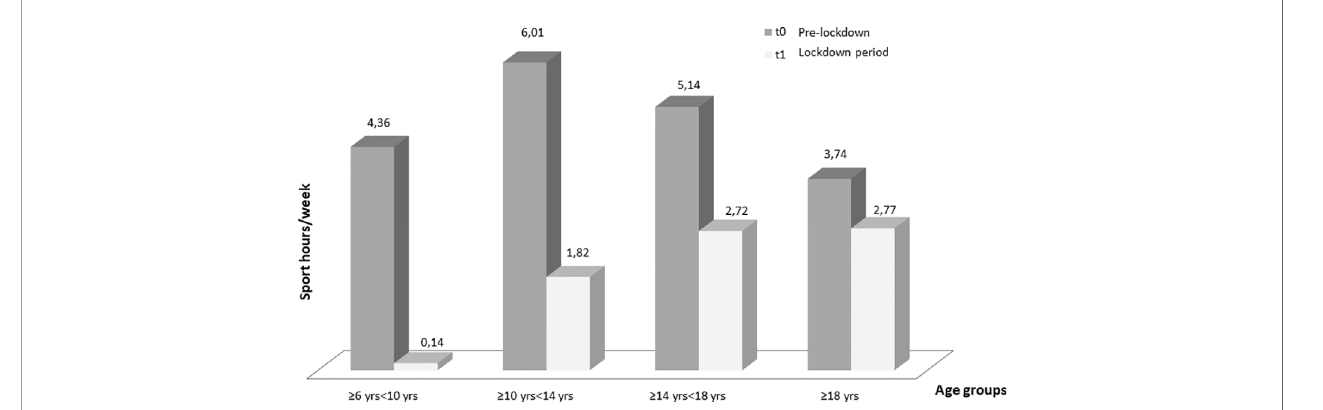
FIGURE 1 | Changes in weekly sports hours for each age at T0 (before the lockdown) and at T1 (lockdown period). Only one children of seven in “ primary school children ” group maintained physical activity ( Table